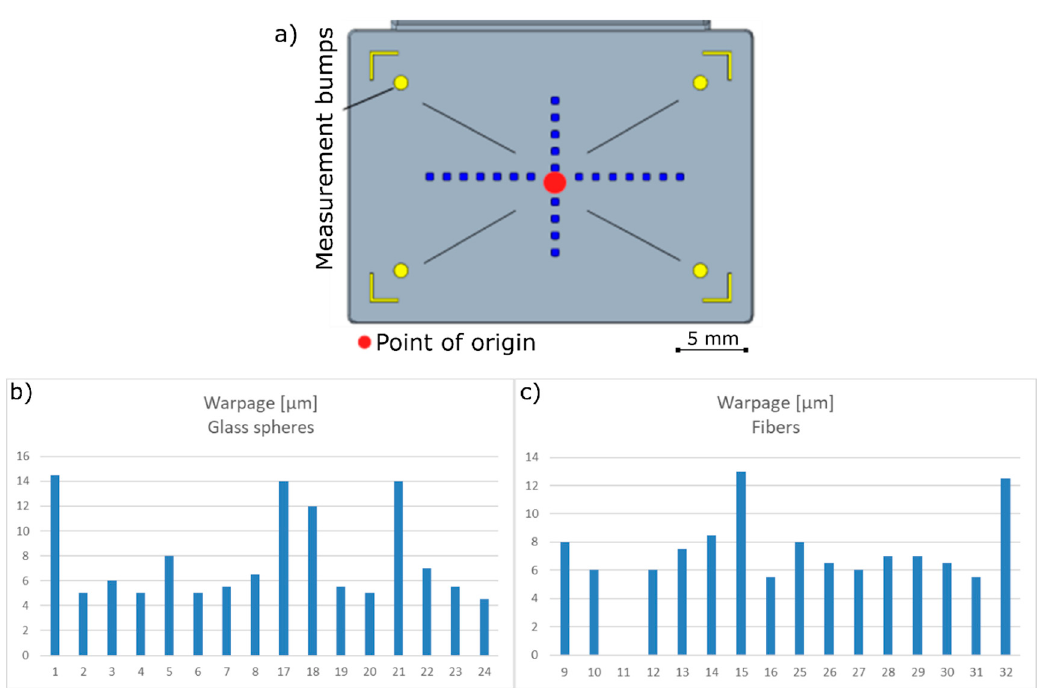
Figure 6. ( a ) measurement field for warpage detection. ( b ) Measured values of the warpage of glass sphere filled material with a standard deviation of 3.56 µ m. ( c ) Measured values of the warpage of fiber filled material with a standard deviation of 2.22 µ m.